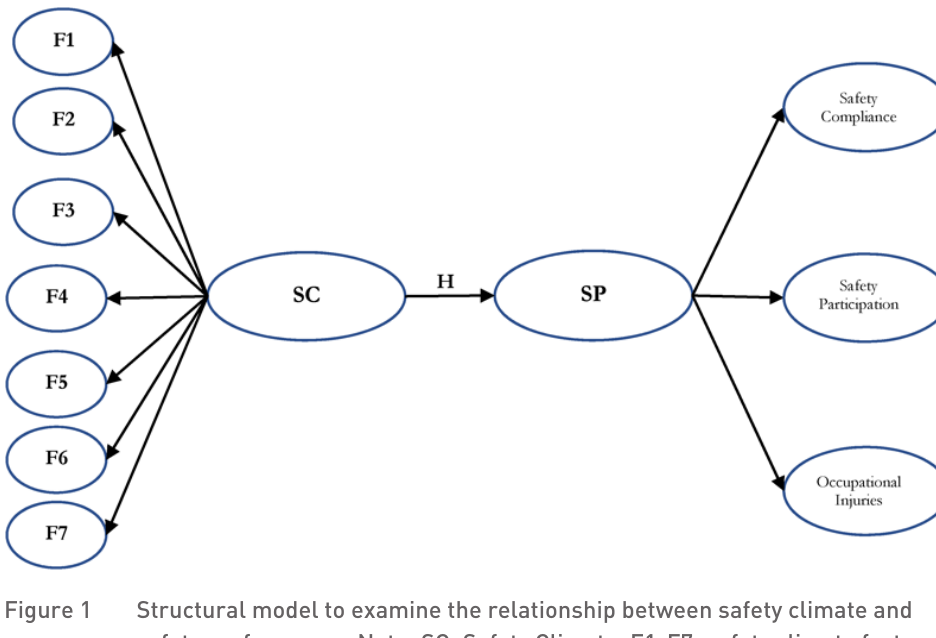
Structural model to examine the relationship between safety climate and safety performance. Note: SC: Safety Climate, F1-F7: safety climate factors, SP: Safety